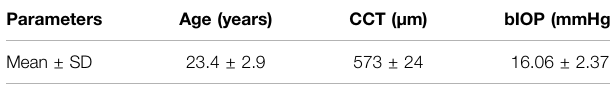
TABLE 1 | Baseline information of the human eyes. Parameters